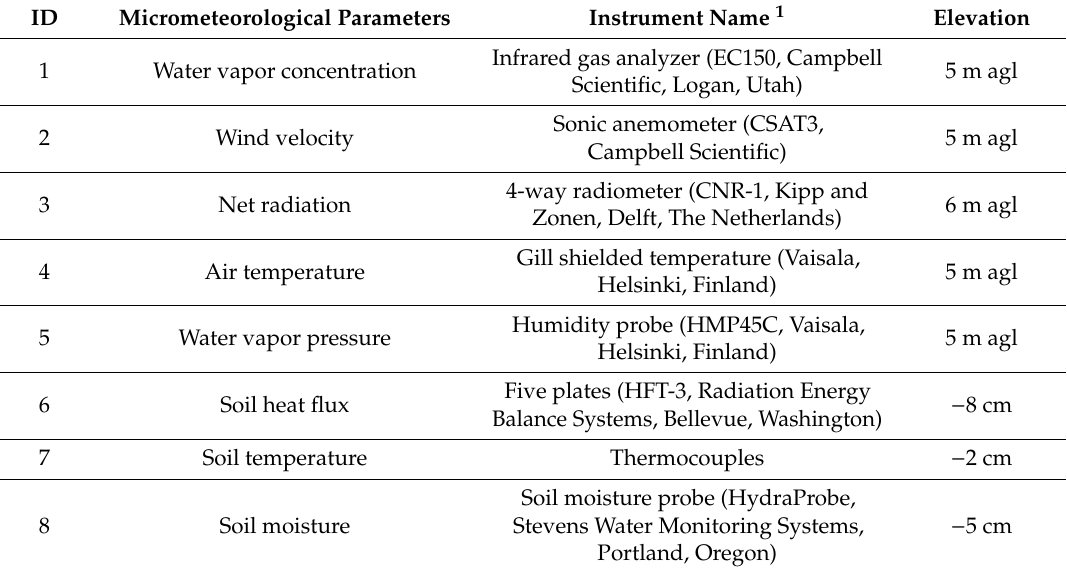
Table 2. Description of in-situ micrometeorological measurements in this